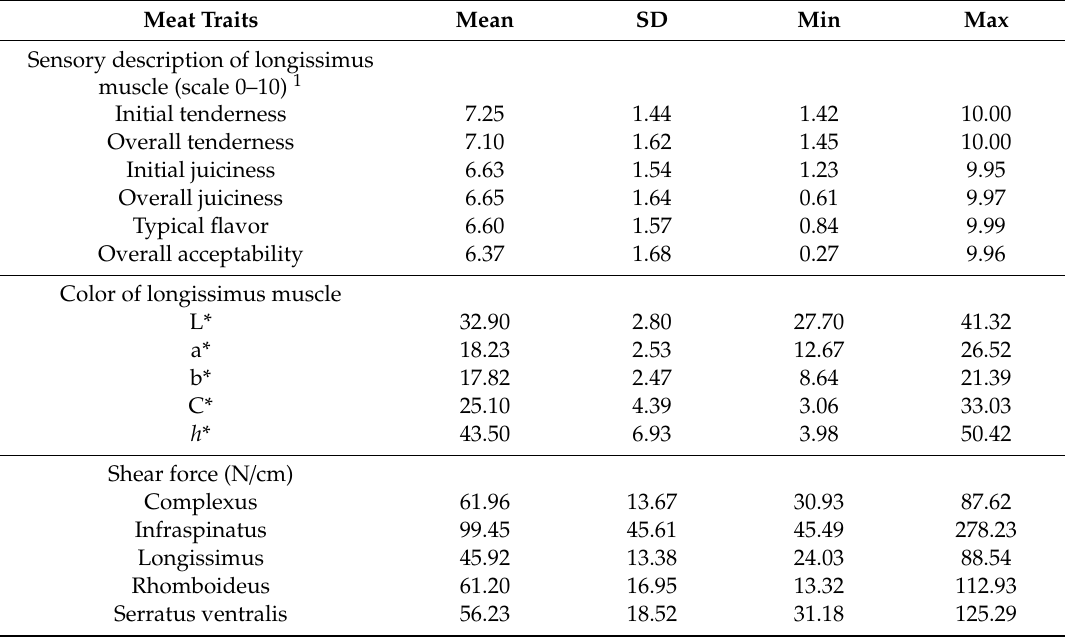
Figure 2. Localization of five rib muscles: complexus (CP), infraspinatus (IF), longissimus (LM), rhomboïdeus (RH), and serratus ventralis (SV). Table 1. Description of the rib muscle traits.